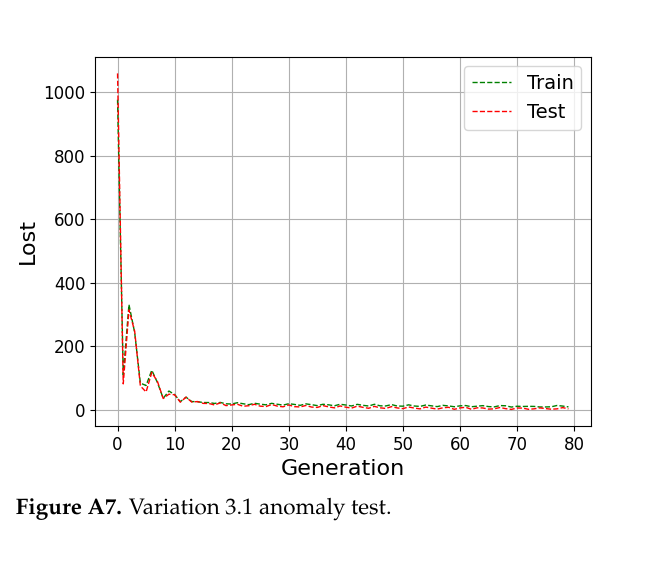
Figure A7. Variation 3.1 anomaly test.